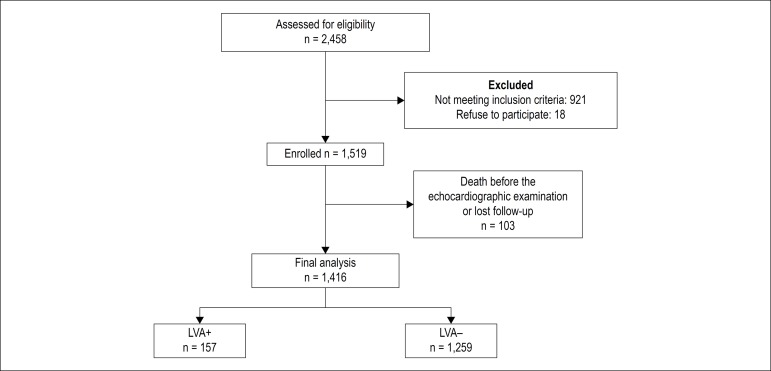
Patients flow chart demonstrating the number of patients eligible for inclusion into the study.